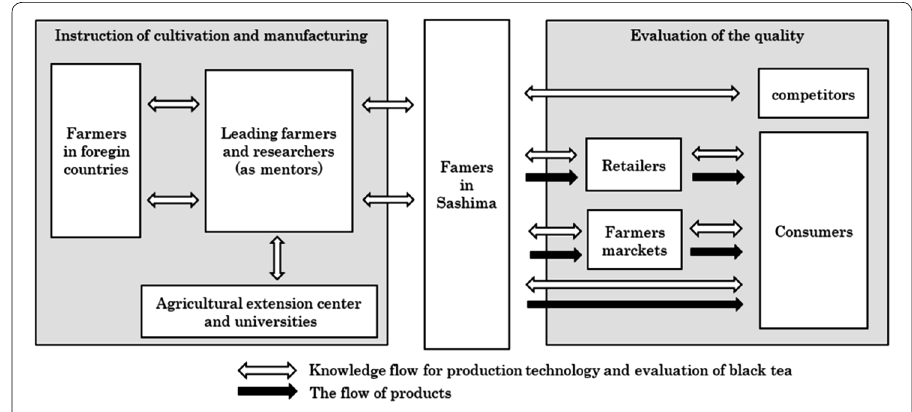
Fig. 6 Knowledge and products flow in